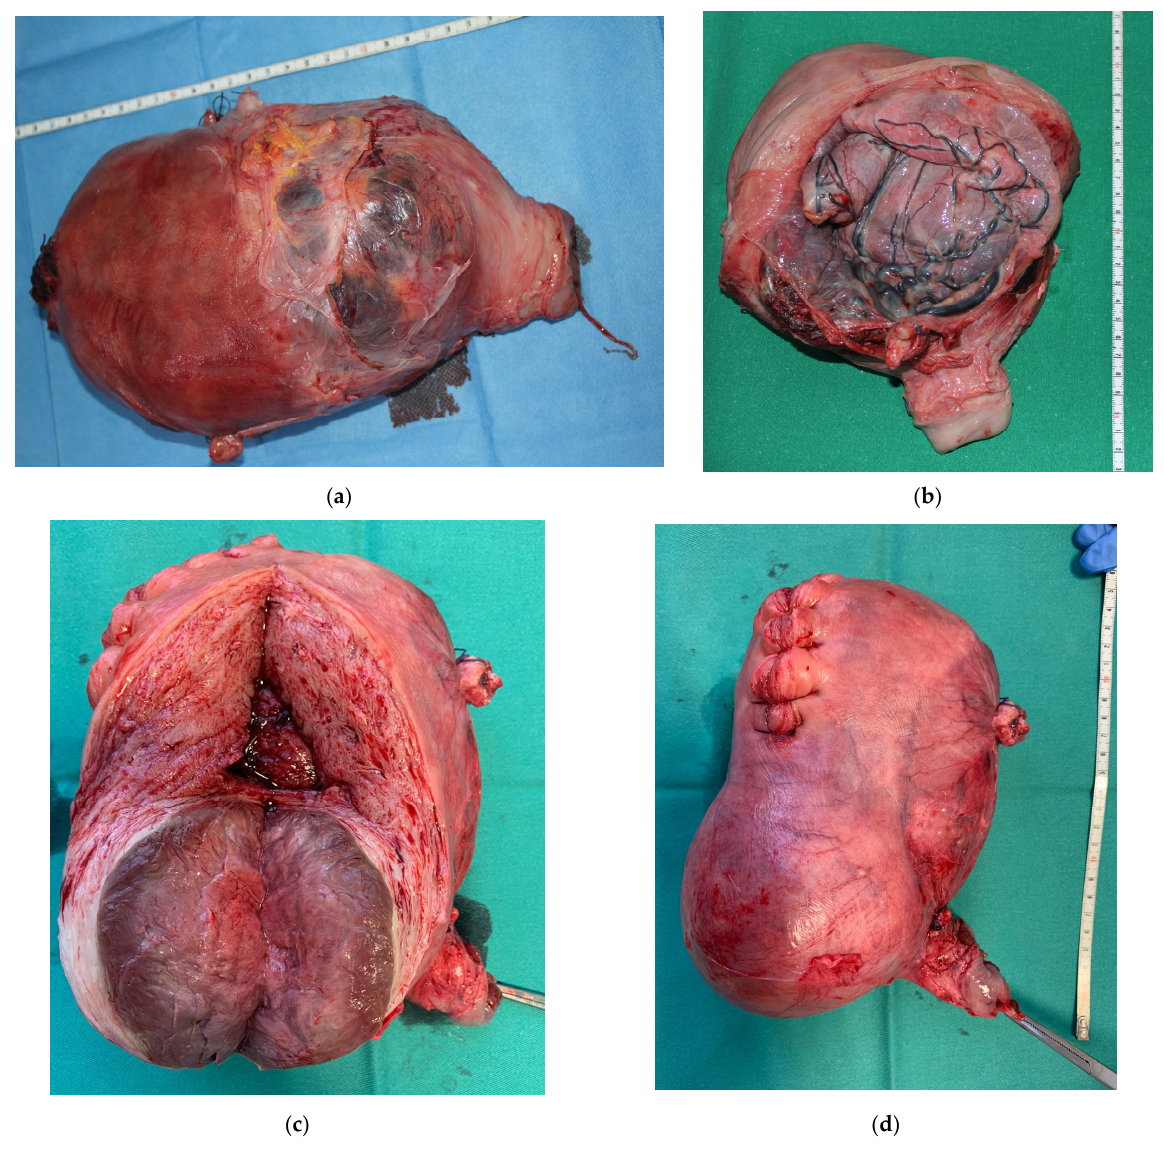
Figure 1. Different aspects of the removed uterus. ( a ) A case of placenta percreta; ( b ) A case of placenta increta; ( c , d ) previa uterine myoma.